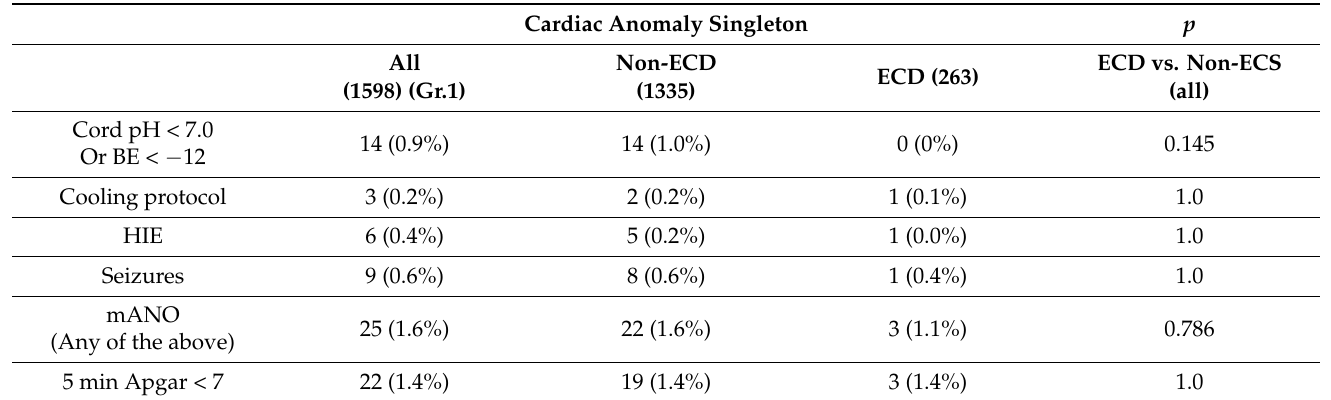
Table 4. Neonatal outcome for singleton neonates with cardiac anomaly (all vs. Elective